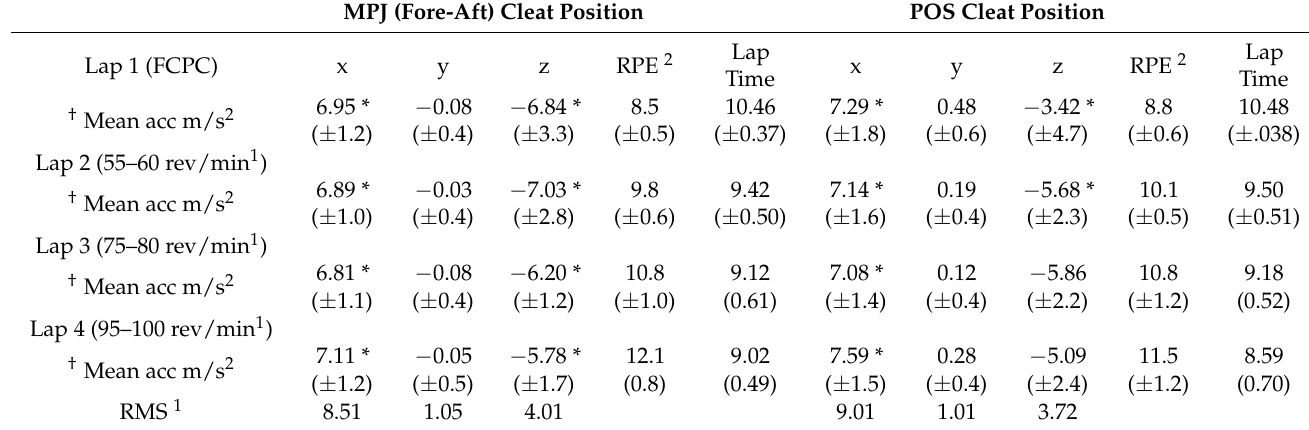
Table 3. Descriptive data (means ± SD) from individual 5 km laps of the overground cycle in two cleat positions (in m/s 2 ). 1 RMS = root mean square. 2 RPE = ratings of perceived exertion. 3 Mean Diff = difference between MPJ and posterior (POS) cleat positions. Lap time reported in minutes.